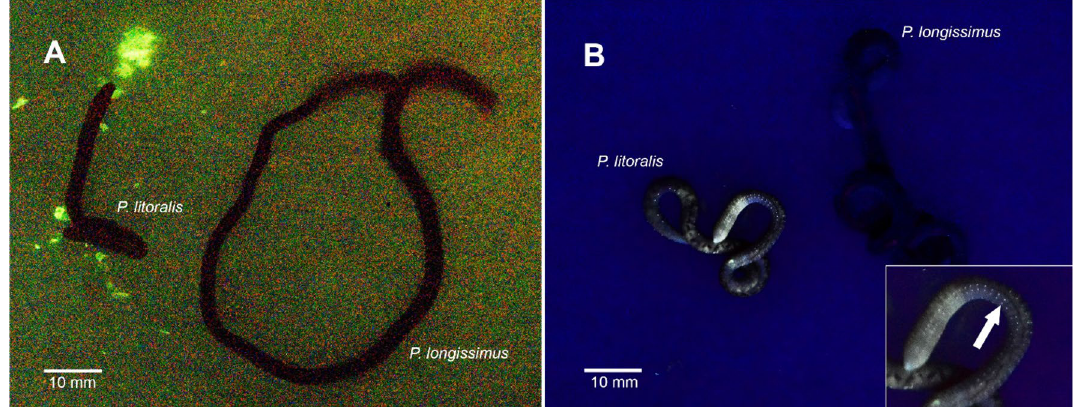
Figure 1. ( A ) Bioluminescence of littoral earthworms after mechanical stimulation. ( B ) Fluorescence observed under a handheld longwave UV lamp (365 nm). Inset: magnified image of P. litoralis . The arrow indicates a row of setae.